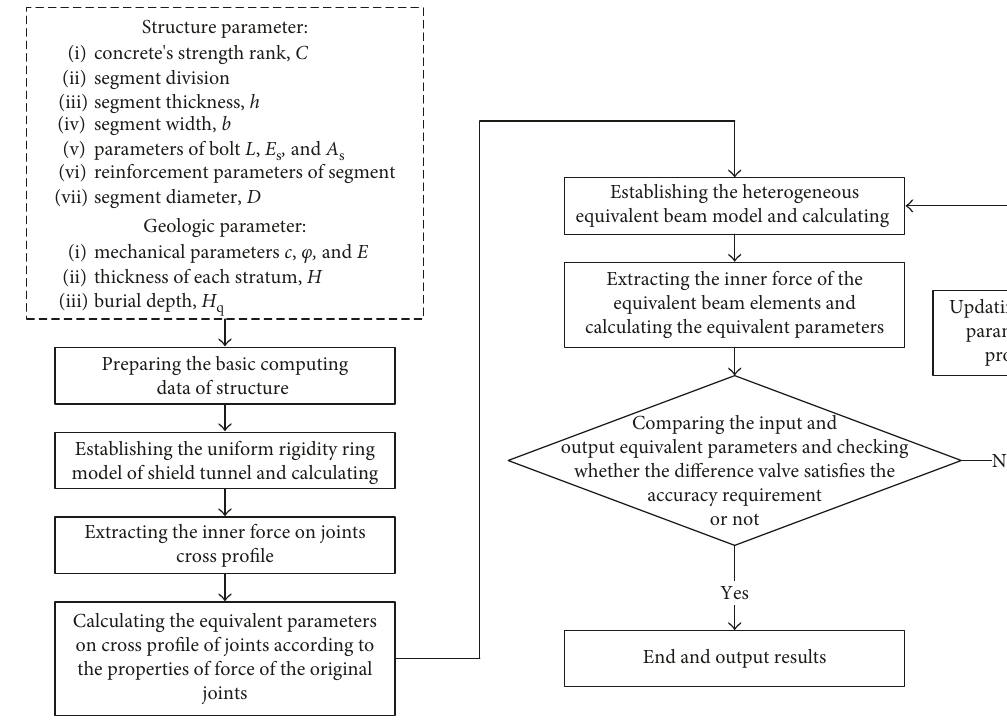
Figure 8: Calculation flow of the HEB model.